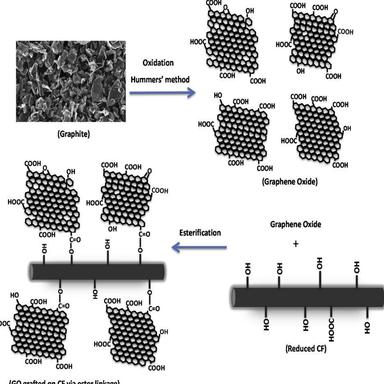
Schematic of formation of GO using Hummers' method followed by grafting reaction between GO and reduced CF to graft GO on CF via ester linkage.